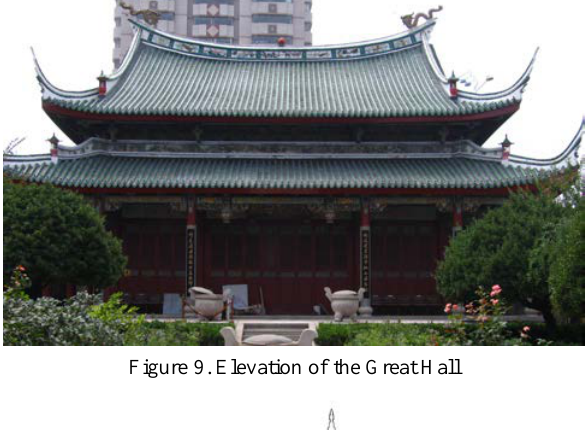
Figure 9. Elevation of the Great Hall